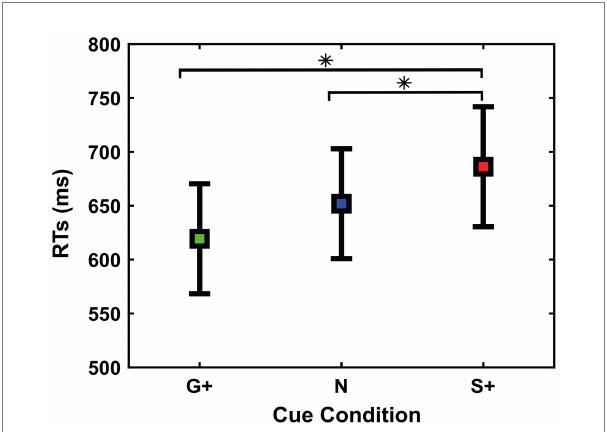
FIGURE 2 Reaction times [RTs (ms)] (mean and ± 1SEM) of Go Trials in the different cue conditions (G+, N,